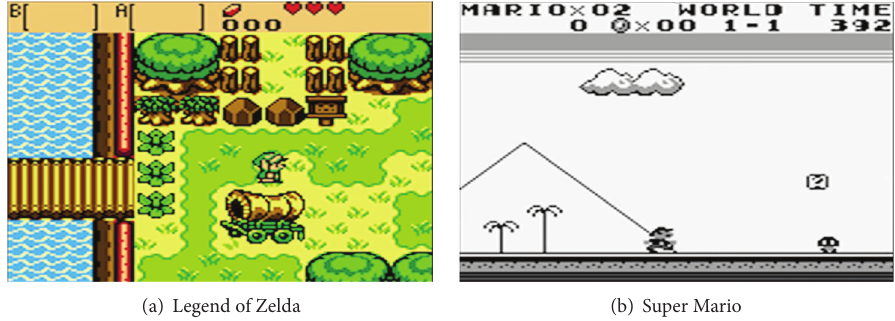
Figure 8: Examples of games available in the Piglet